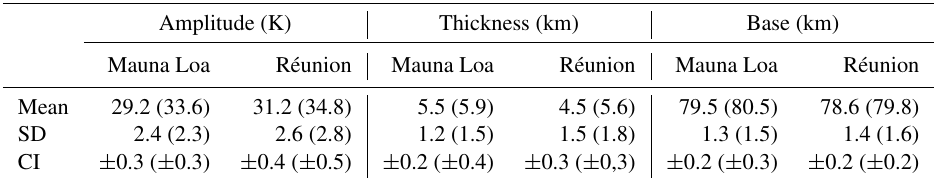
Table 1. The inversion characteristics at Réunion and Mauna Loa from lidar. The inversion characteristics obtained from SABER are reported in parentheses. The confidence interval of the mean is calculated at 95%